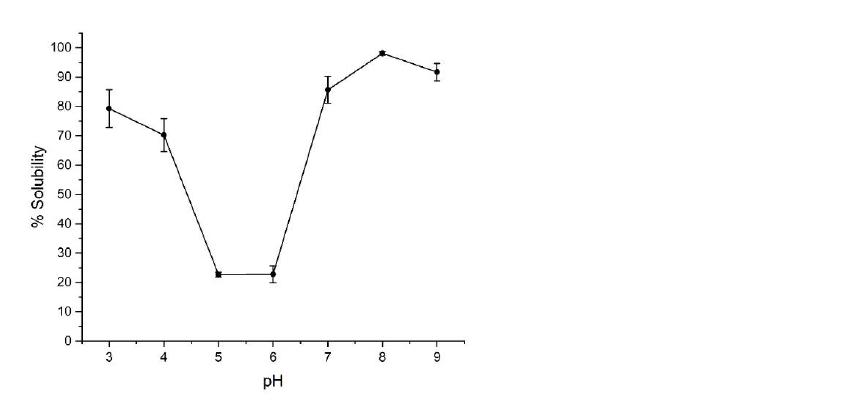
Figure 1. Experimental β -vignin solubility assessment according to pH conditions. See Materials and Methods for buffer composition. The concentration of the protein was 0.5 mg/mL.